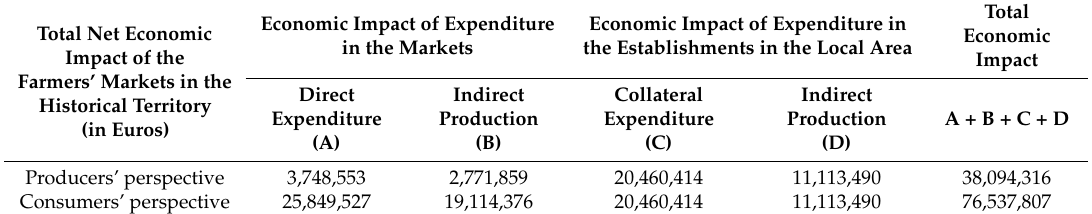
Table 5. Total net economic impact of the farmers’ markets in the historical territory (in euros).